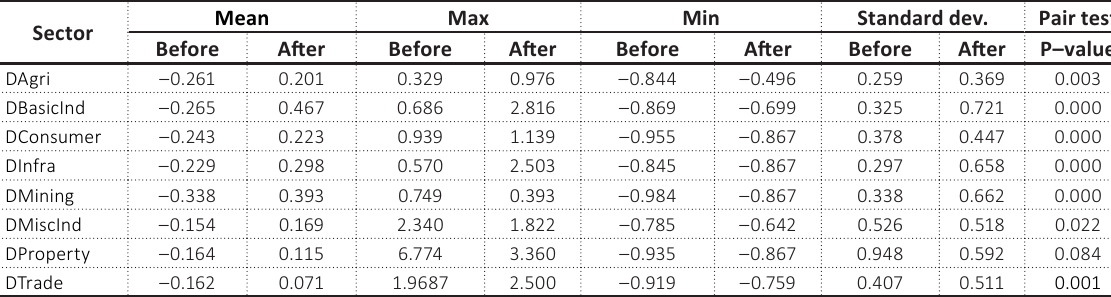
Table 6. Sectoral returns before and after the COVID-19